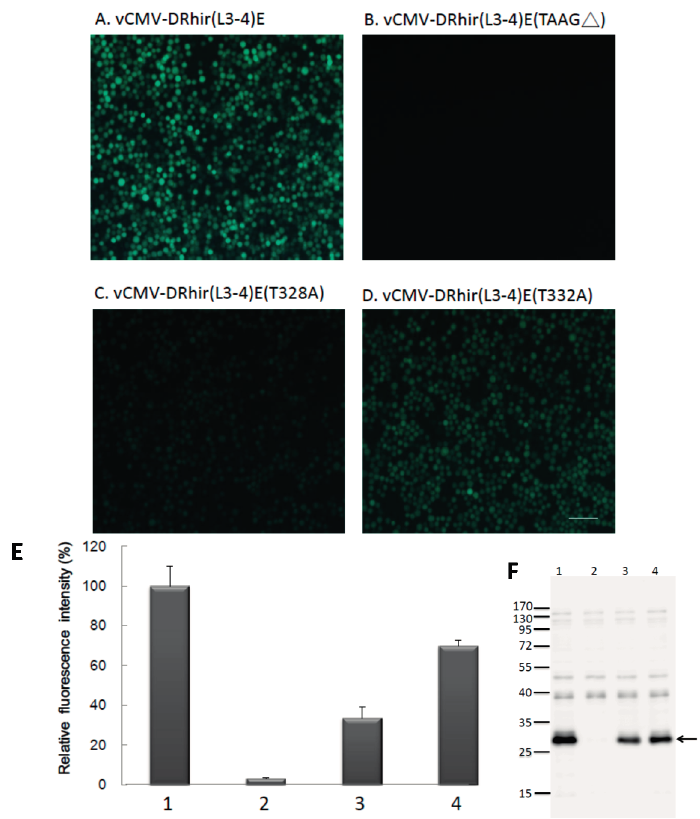
Figure 4. ( A – D ) The L3 TAAG motifs but not the L4 in the cDNA of RhPV 5 ′ IRES are dominant for RP110 promoter activity in baculovirus infected Sf21 cells. Fluorescence micrographs of Sf21 cells infected with ( A ) vCMV-DRhir(L3-4)E; ( B ) vCMV-DRhir (L3-4)E(TAAG ∆ ); ( C ) vCMV-DRhir(L3-4)E(T328A); and ( D ) vCMV-DRhir(L3-4)E (T332A) at a multiplicity of infection of 1 at 3 days post-infection. Pictures were taken under a FITC channel with a 450/490-nm filter set using an exposure time of 900 ms; scale bar is 50 μ m; ( E , F ) Quantitative analysis of promoter activity in the truncated and mutations in the RP110 cryptic promoter by spectrofluorometer and Western blot; ( E ) Spectrofluorometric measurement of EGFP fluorescence in lysates (100 μ L; 50 μ g of protein) from Sf21 cells infected with (1) vCMV-DRhir(L3-4)E, (2) vCMV-DRhir(L3-4)E (TAAG ∆ ), (3) vCMV-DRhir(L3-4)E(T328A), or (4) vCMV-DRhir(L3-4)E (T332A) at a multiplicity of infection of 1 at 3 days post-infection. EGFP fluorescence emission was excited at 488 nm and monitored at 507 nm. The fluorescence intensity of EGFP was normalized to that of vCMV-DRhir(L3-4)E infected Sf21 cell lysates (100%); ( F ) Western blot analysis of cellular lysates from Sf21 cells infected with vCMV-DRhir(L3-4)E (Lane 1), vCMV-DRhir(L3-4)E (TAAG ∆ ) (Lane 2), vCMV-DRhir(L3-4)E (T328A) (Lane 3), vCMV-DRhir(L3-4)E(T332A) (Lane 4). Proteins (25 μ g per lane) were separated by 12% SDS–PAGE and then electrotransferred onto PVDF membranes, which were then incubated with rabbit anti-GFP polyclonal antibody followed by an HRP-conjugated goat anti-rabbit secondary antibody. Detected protein bands were visualized on X-ray film using a Western blot chemiluminescence kit. Molecular mass markers (kDa) are indicated at left and the arrow indicated the EGFP protein